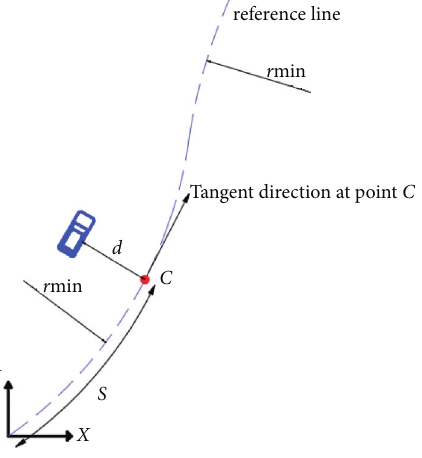
Figure 17: Frenet coordinates system. Table 2: The parameters of risk